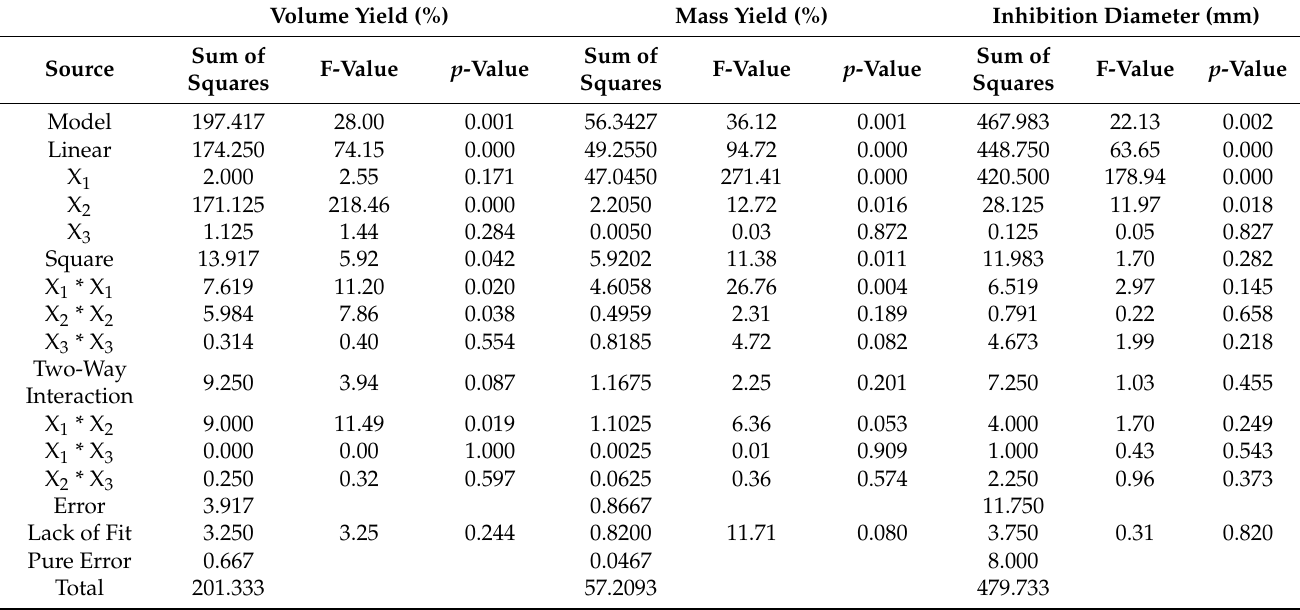
Table 2. Analysis of variance for the regression models of volume yield, mass yield, and inhibition diameter of S. aureus ATCC 6538.